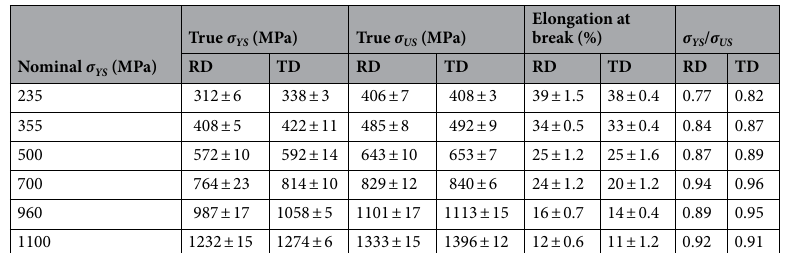
Table 2. Mechanical properties obtained from stress–strain